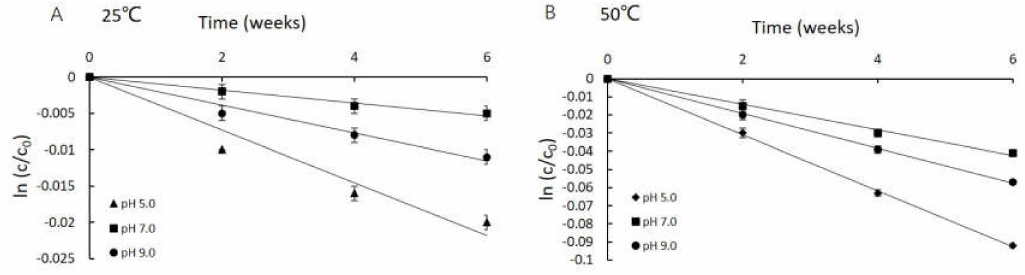
Figure 5. Plots of − ln (C t / C 0 ) versus time for samples stored at di ff erent pH values and temperatures of 25 ◦ C and 50 ◦